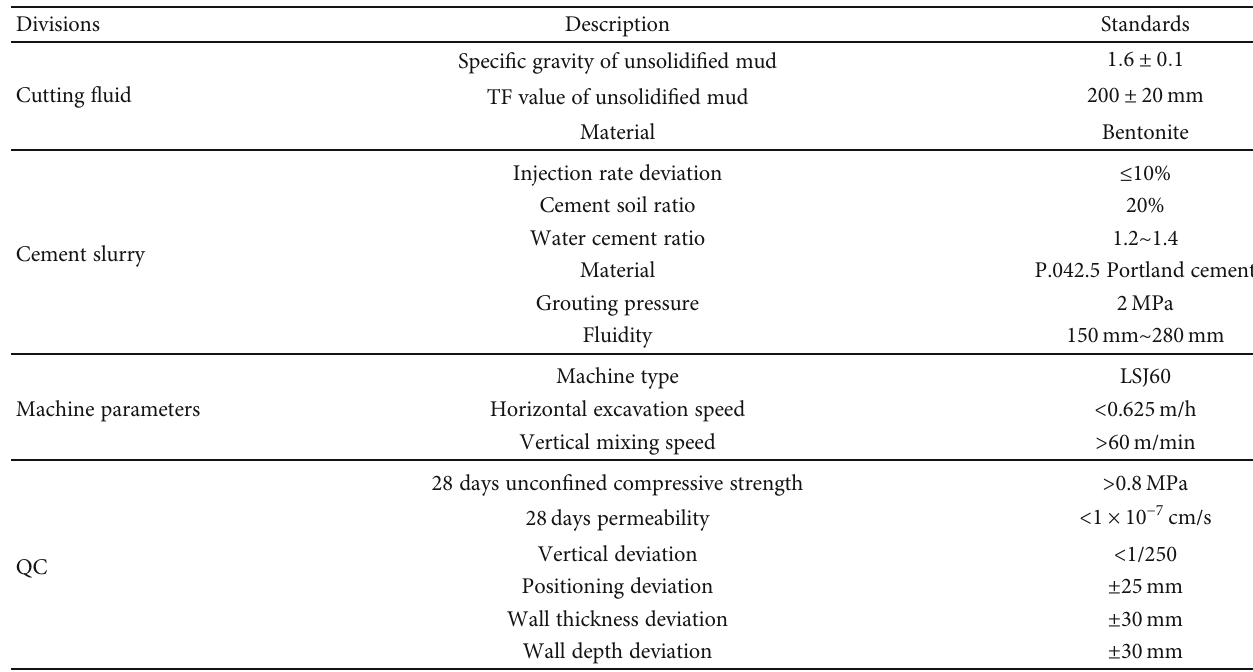
Table 2: TRD main design